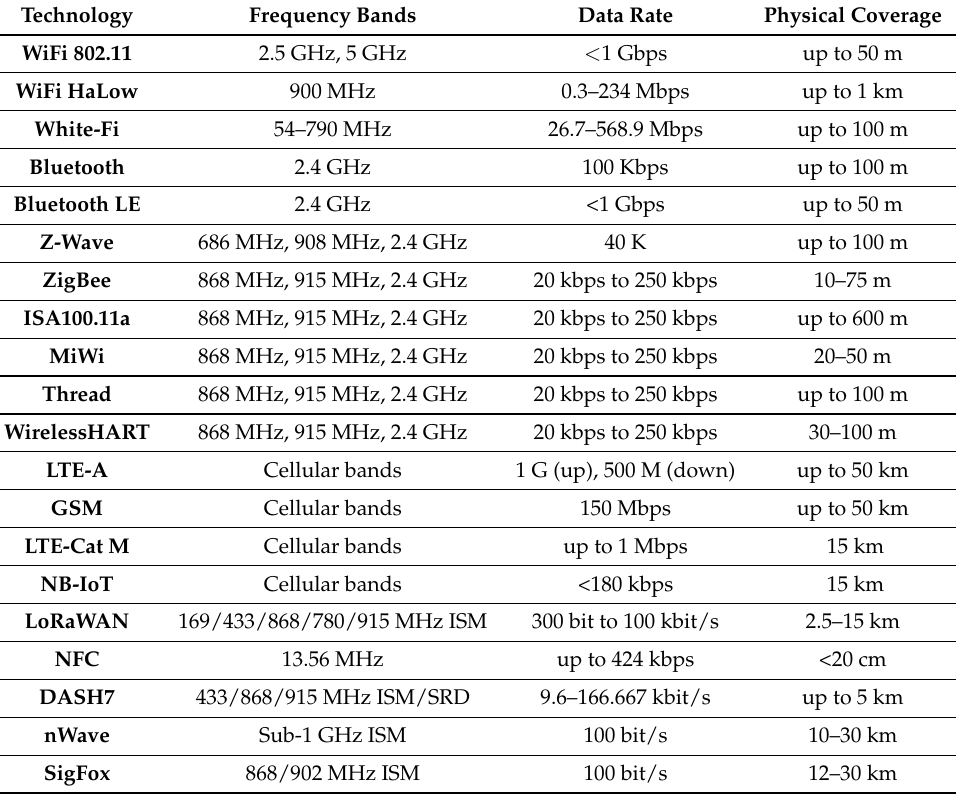
Table 2. IoT enabling technologies, their frequency bands and data